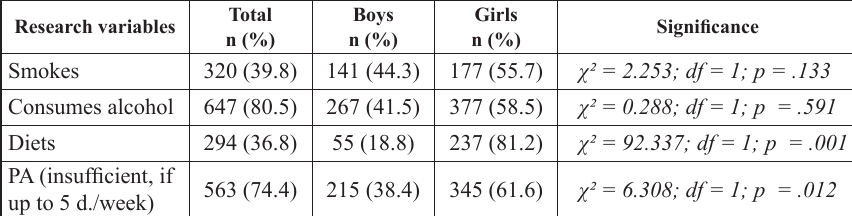
Table 1. The expression of harmful habits and insufficient level of physical activity in the total sample and in the groups of boys and girls, %